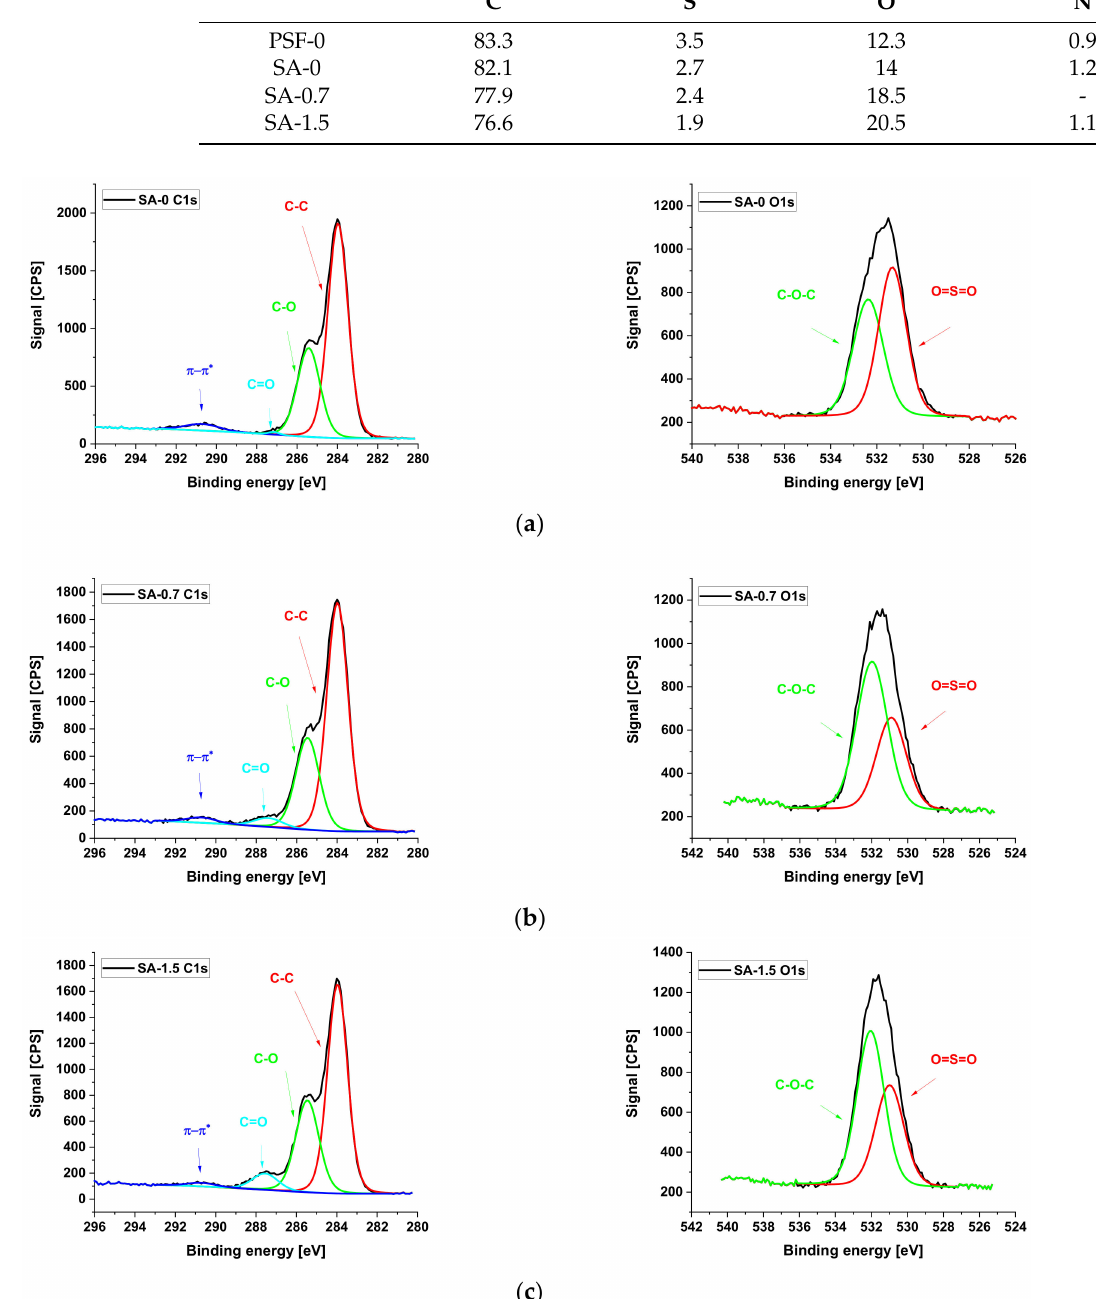
Figure 2. XPS spectra analysis of the selective layer of PSF/Synperonic F108 and PSF/Synperonic F108/PAA membranes: ( a )—SA-0; ( b )—SA-0.7; ( c